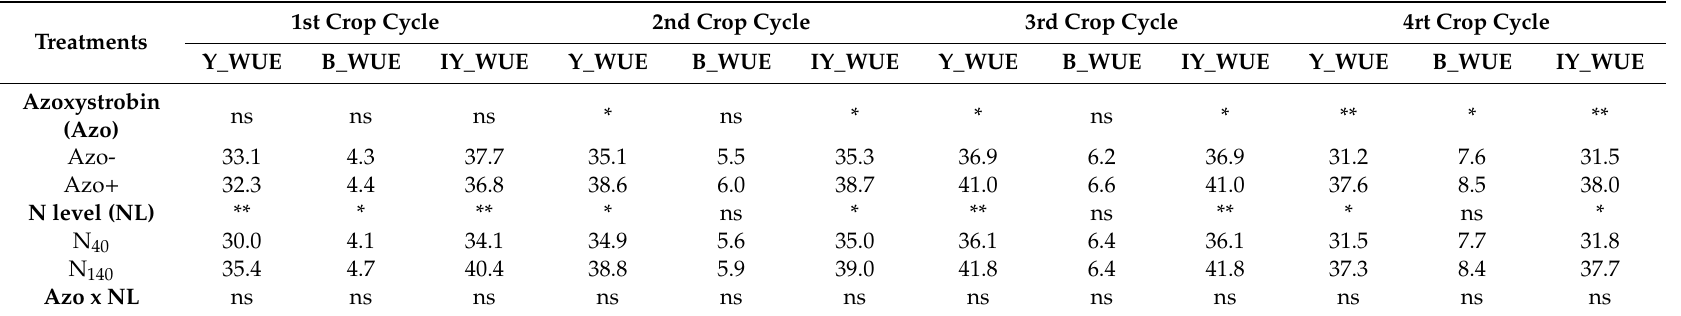
Table 3. E ff ects of the Azoxystrobin (Azo) application and N level (NL) on: (i) the yield (Y_WUE, kg m − 3 ) and biomass (B_WUE, kg m − 3 ) water use e ffi ciency, and (ii) the irrigation yield water use e ffi ciency (IY_WUE, kg m − 3 ) of wild rocket in the four crop cycles. Azo − = control without Azoxystrobin, Azo + =